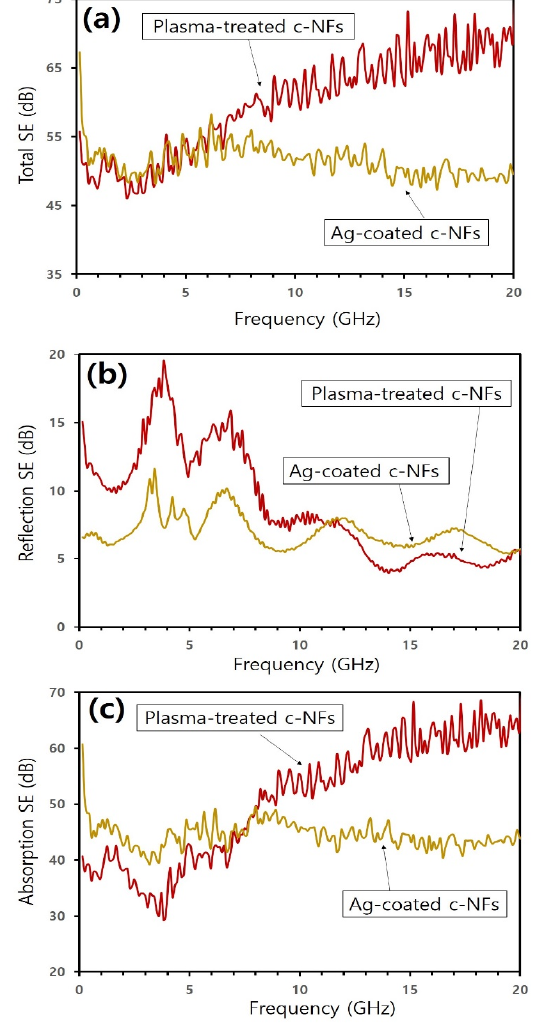
Figure 9. ( a ) Total SE spectra; ( b ) components of SE spectra owing to reflection; and ( c ) components of SE spectra owing to absorption for both plasma-treated and Ag-coated c-NFs samples.